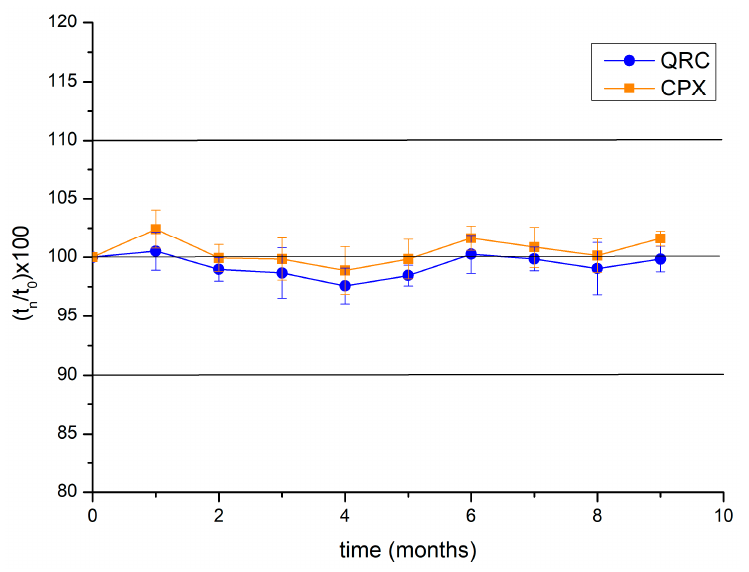
Figure 15. Percentage of CPX ( ● ) and QRC ( ■ ) content variation into the BioQ-CPX as a function of time (months); means ± SE ( n = 3).